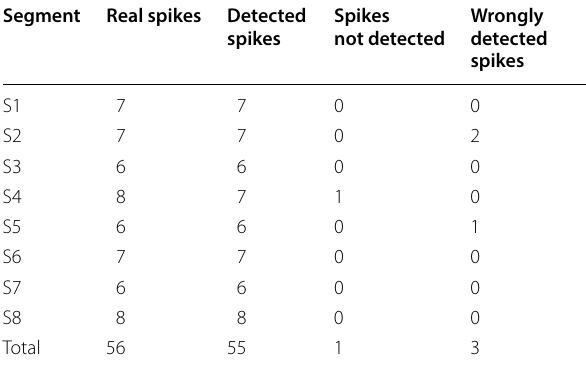
Table 6 Results of final